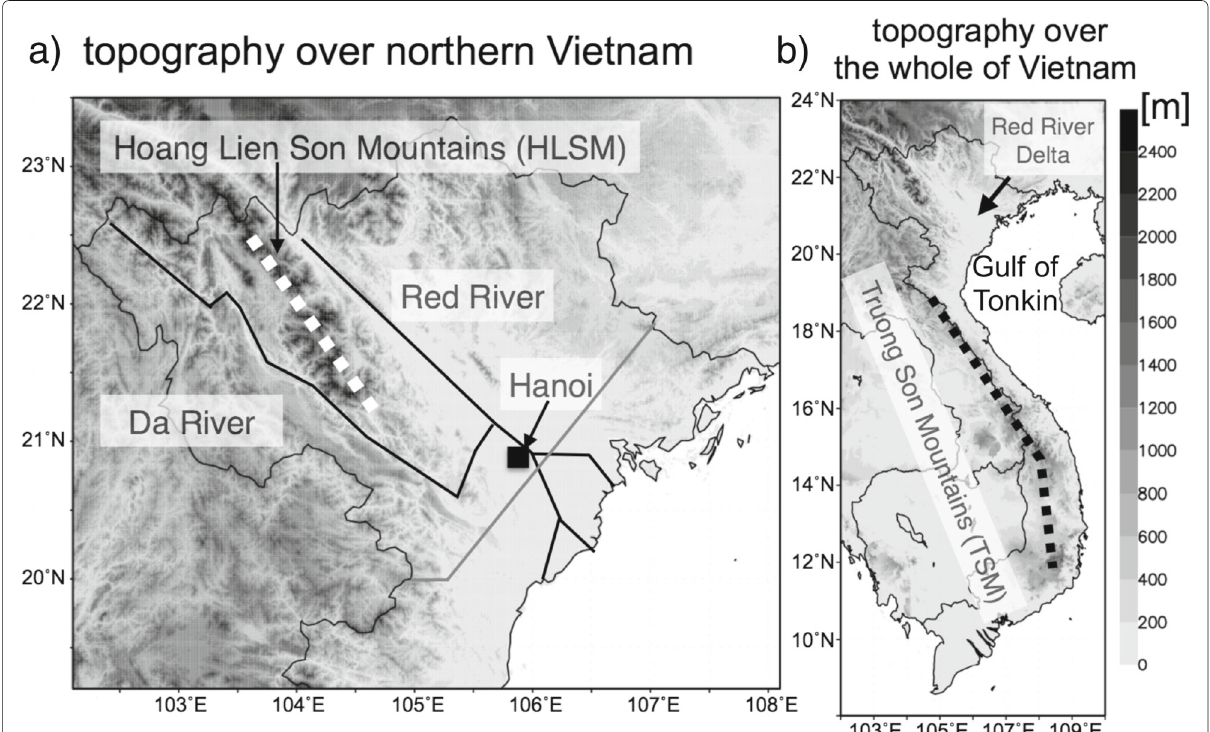
Fig. 1 Topography (gray shading) over a northern Vietnam and b the whole of Vietnam. The green line shows the southeastern limit of the region chosen for regional mean precipitation calculation, as shown in Figs. 4 and 5 and Table 2. Thick broken lines show the approximate positions of mountain